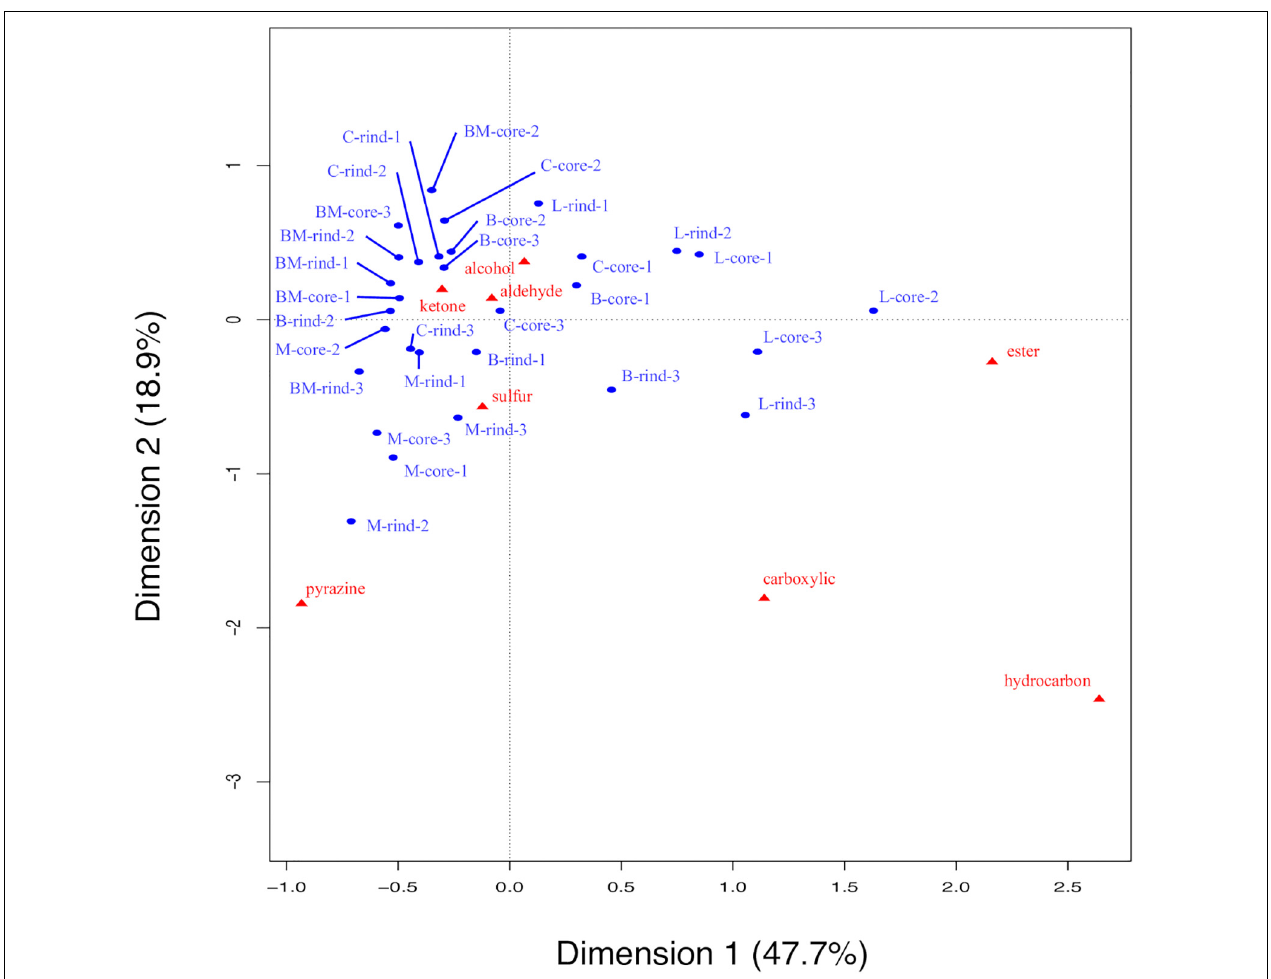
FIGURE 8 | Biplot of principal coordinates and standard coordinates obtained by correspondence analysis (CA) for volatile compounds in 30 cheese samples. Detected compounds were classified into eight categories (alcohols, aldehydes, carboxylic acids, esters, hydrocarbons, ketones, pyrazines, and sulfur compounds). Blue plot indicates principal coordinates and red plot indicates standard coordinates. B, Brie de Meaux; BM, Brie de Melun; C, Coulommiers; L, Langres; M,